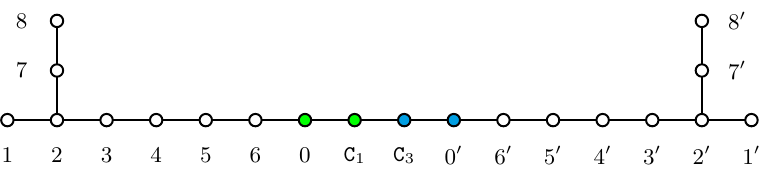
Figure 6. Extended diagram with A 1 = (cid:14) 1 (cid:2) 0, A 2 = 0 (cid:2) (cid:14) 0 II 2 ; 18